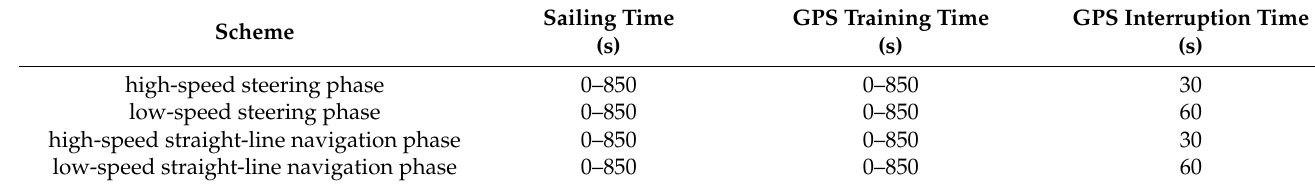
Table 3. Setting of GPS interruption during prediction.